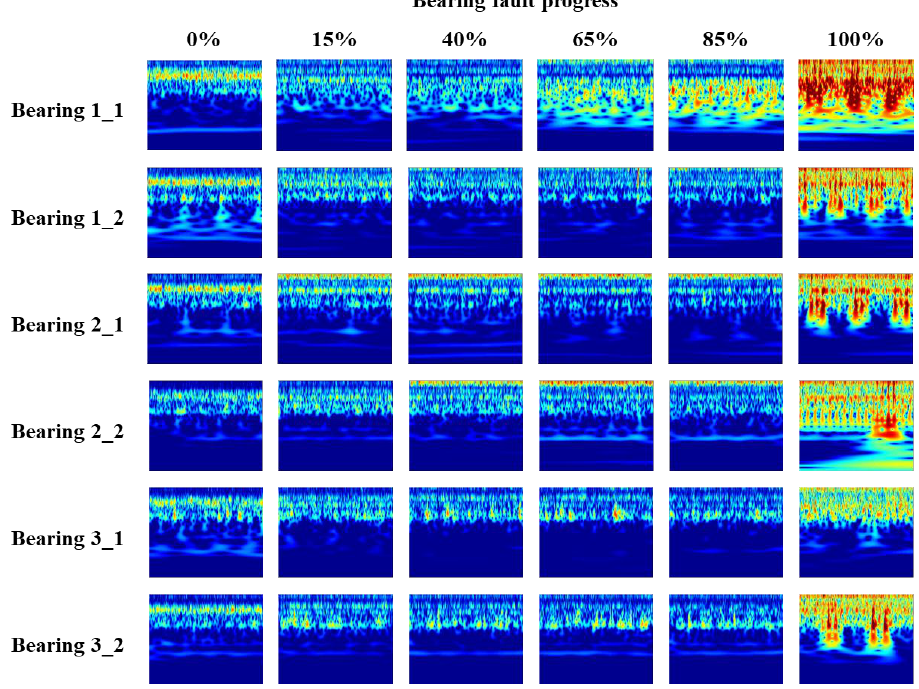
Figure 7. Contour plots of wavelet power spectrum during the run-to-failure experiment of the training bearings.